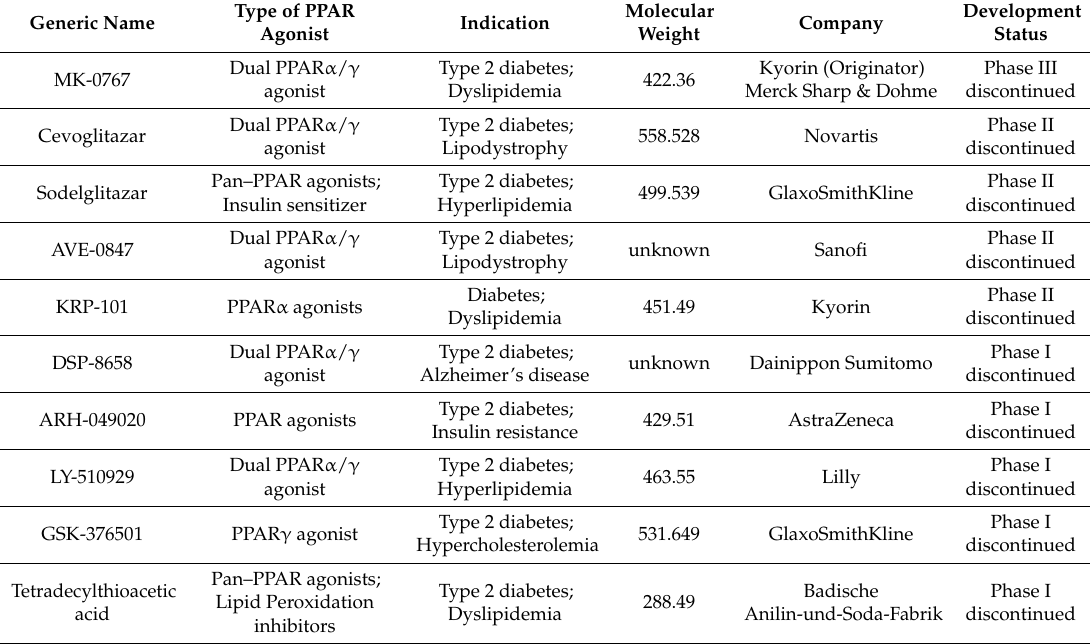
Table 7. Drugs of PPAR ligands for treatment of diabetic associated complications terminated in clinical